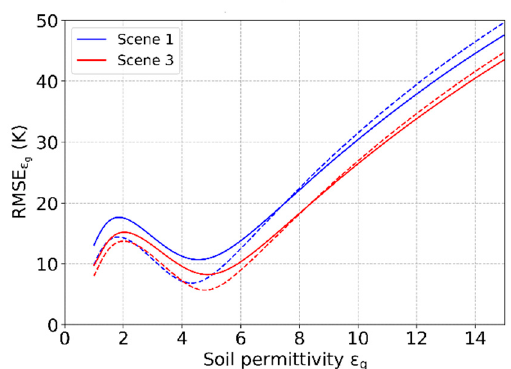
Figure 2. RMSE ε g ) obtained from Dense Media Radiative Transfer-Multi Layer (DMRT-ML) simulations and angular radiometer measurements performed in November 2015 on snow-free frozen soil on Scene 1 (blue) and 3 (red) for different values of soil permittivity ( ε g ) with a specular soil reflectivity model. RMSE ε g including all incidence angles (solid lines) and without 60° (dashed lines) are represented.